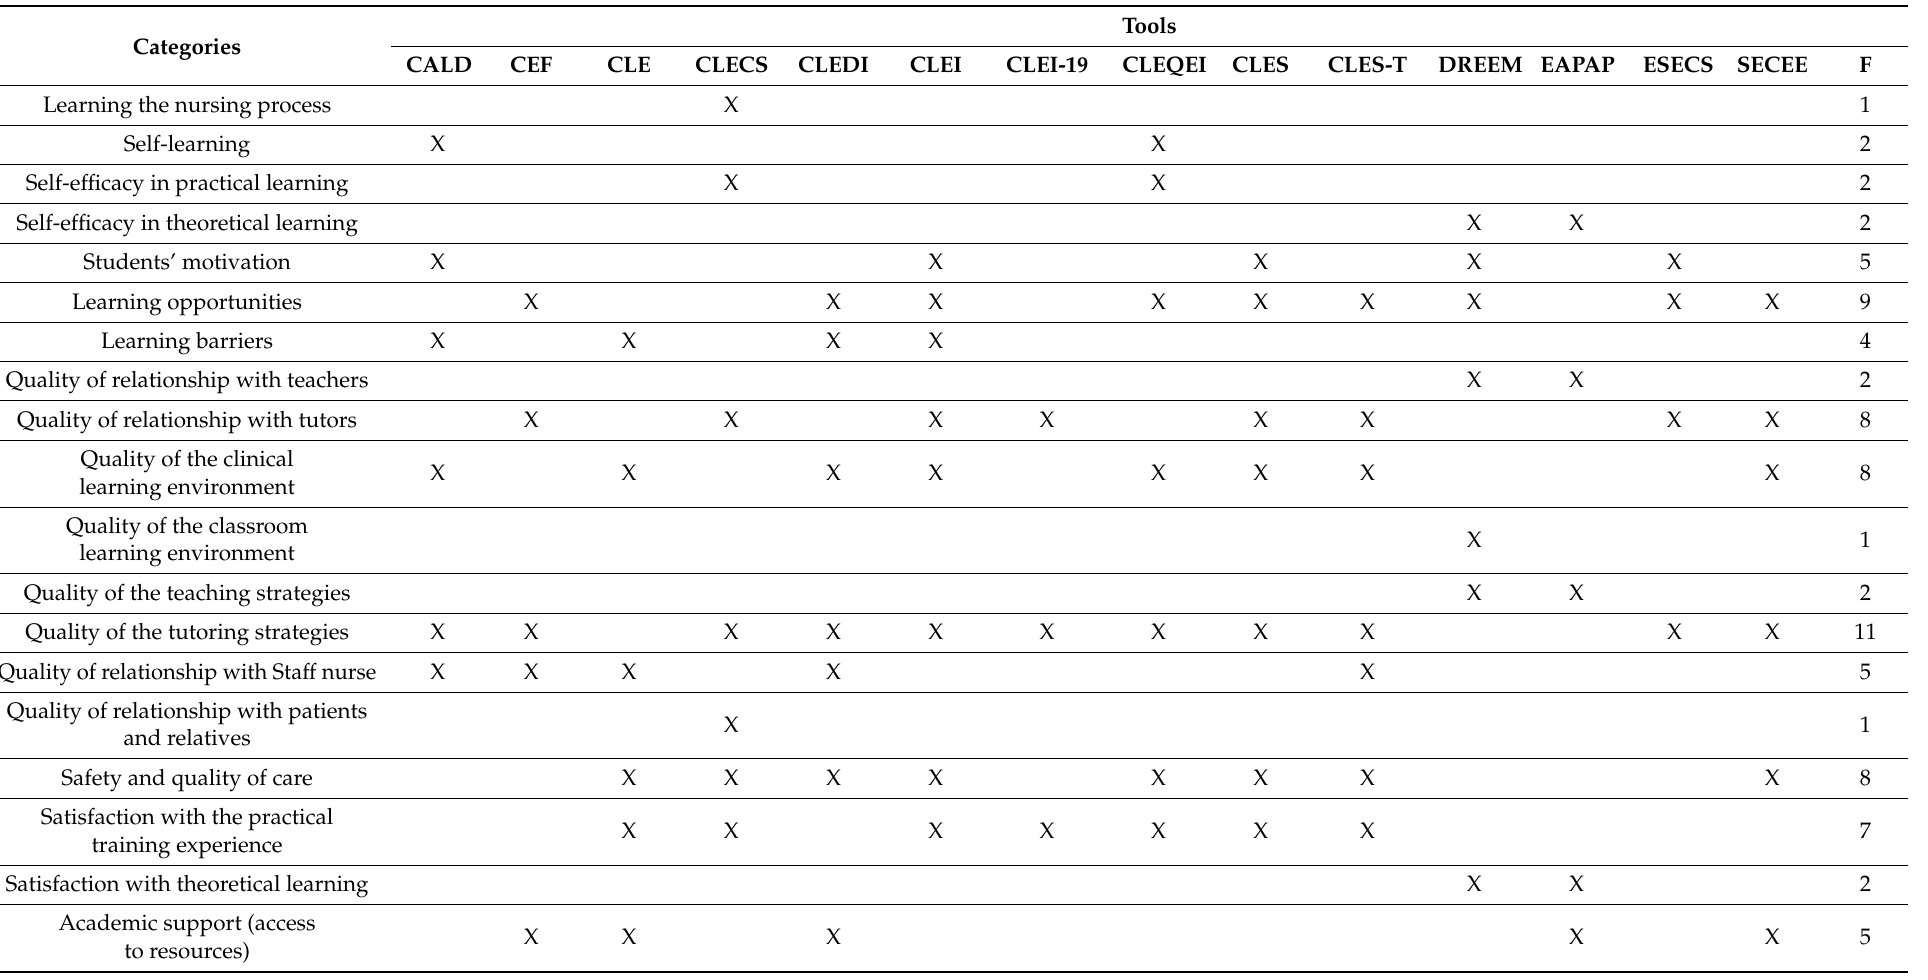
Table 3. Categories associated with